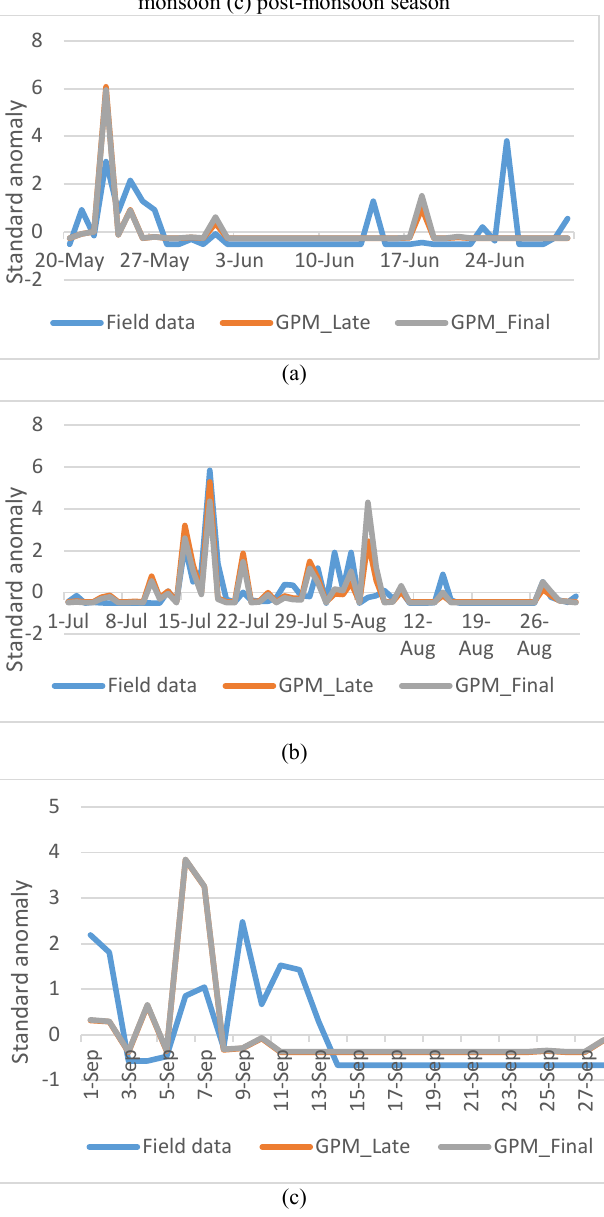
Figure 5. Comparison of NIH field data with GPM-IMERG late and final run precipitation data for 2014 (a) pre-monsoon (b) monsoon (c) post-monsoon season